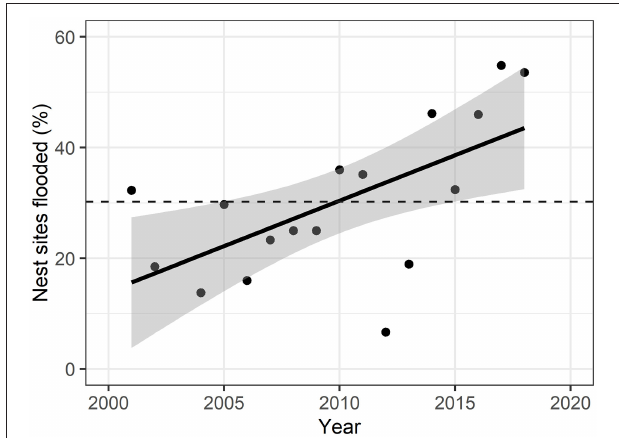
FIGURE 3 | Relation of flooded nest sites and juvenile Siberian cranes counted at Momoge Nature Reserve in the fall of the same year (as indicated in point labels). The solid line represents a linear regression (adjusted R 2 = 0.58), with gray areas representing 95% confidence